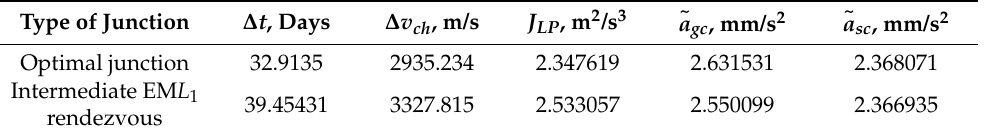
Figure 8. The projection of optimal 18-revolution trajectories from GTO with low perigee altitude of 300 km to elliptical lunar orbit onto the XY plane in the rotating coordinate system. Table 5. The results of the optimal 18-revolution trajectories from GTO with perigee altitude of 300 km to elliptical lunar orbit.